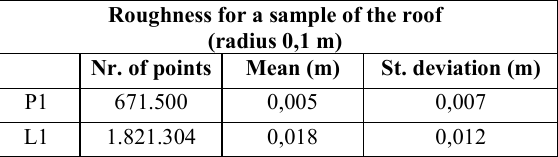
Table 9. Roughness analyses of the roof section.